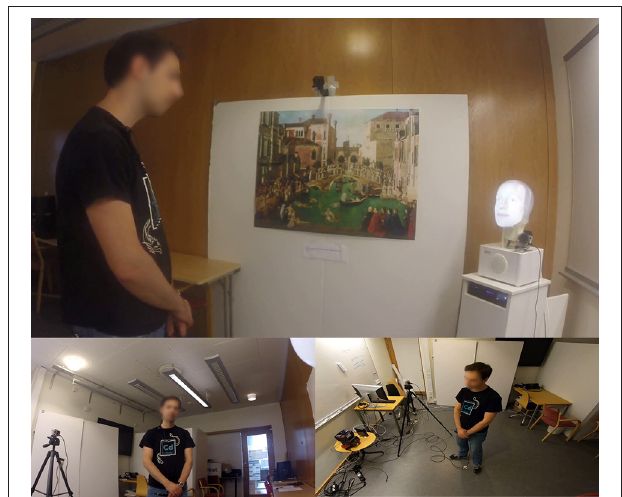
FIGURE 1 | A snapshot of an experiment participant, shown from all three angles from which we recorded them. The participant’s face has been blurred for privacy. Top: the participant is shown from behind, illustrating the set-up of our experiment, with the presenting Furhat head visible.